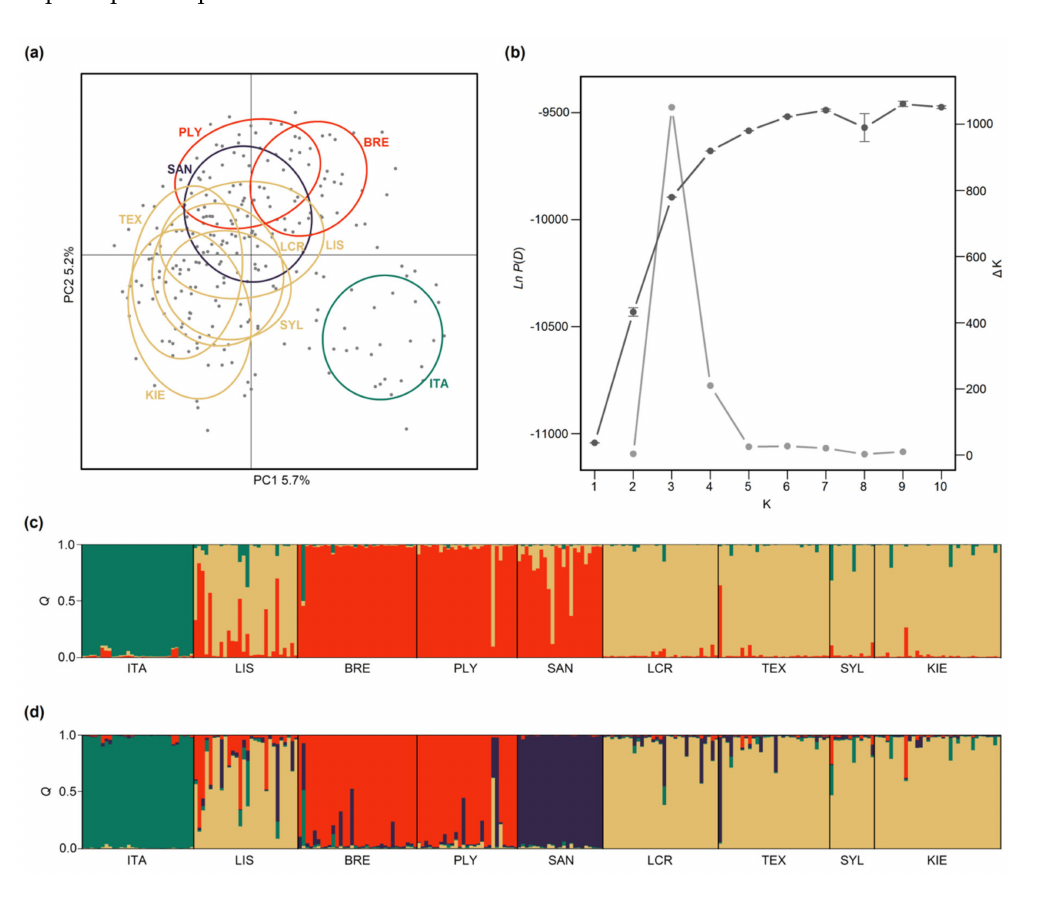
Figure 3. Results of genetic analysis of 247 soft-shell clams genotyped at 11 microsatellites. ( a ) A scatterplot of individual variation in principal component (PC) scores derived from principal component analysis (PCA) of the microsatellite dataset. The amounts of variation explained by each PC are given as percentages and the colored ellipses represent 95% confidence intervals for each population; ( b ) Results of the Structure analysis showing mean and standard deviations of estimated Ln probabilities of the data [ P ( D )] (dark grey) and ∆ K (light gray) for each value of the number of groups ( K ); Panels ( c ) and ( d ) show estimated group membership coe ffi cients obtained from Structure analyses with the number of groups ( K ) set to three and four respectively. Each individual is represented by a vertical line partitioned into segments of di ff erent color, the lengths of which indicate the posterior probability of membership to each group. The populations in panel ( a ) have been color-coded according to the four group solution shown in panel ( d